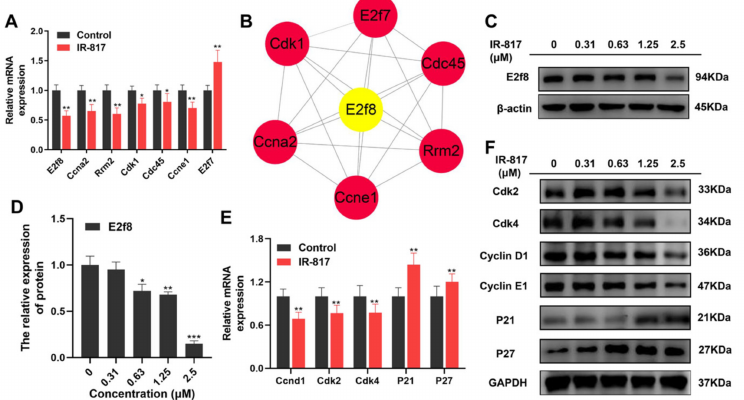
Figure 6. IR-817 induced melanoma cell cycle arrest at the G0/G1 phase by E2F/Cyclin/CDK signal regulation network. ( A ) The mRNA expression of E2f8, Ccna2, Rrm2, Cdk1, Cdc45, Ccne1, and E2f7 were validated by qRT-PCR assay. ( B ) Protein-protein interaction (PPI) network of E2f8, Ccna2, Rrm2, Cdk1, Cdc45, Ccne1, and E2f7. ( C ) E2f8 protein levels. β -actin as an internal reference. ( D ) Statistical analysis of the E2F8 protein levels (mean ± SD, n = 3). ( E ) The mRNA expression of Ccnd1, Cdk2, Cdk4, p21, and p27 were validated by qRT-PCR assay. ( F ) Cyclin D1, Cyclin E1, Cdk2, Cdk4, P21 and P27 protein levels. GAPDH as internal reference. * p < 0.05, ** p < 0.01, *** p < 0.001 compared with the control